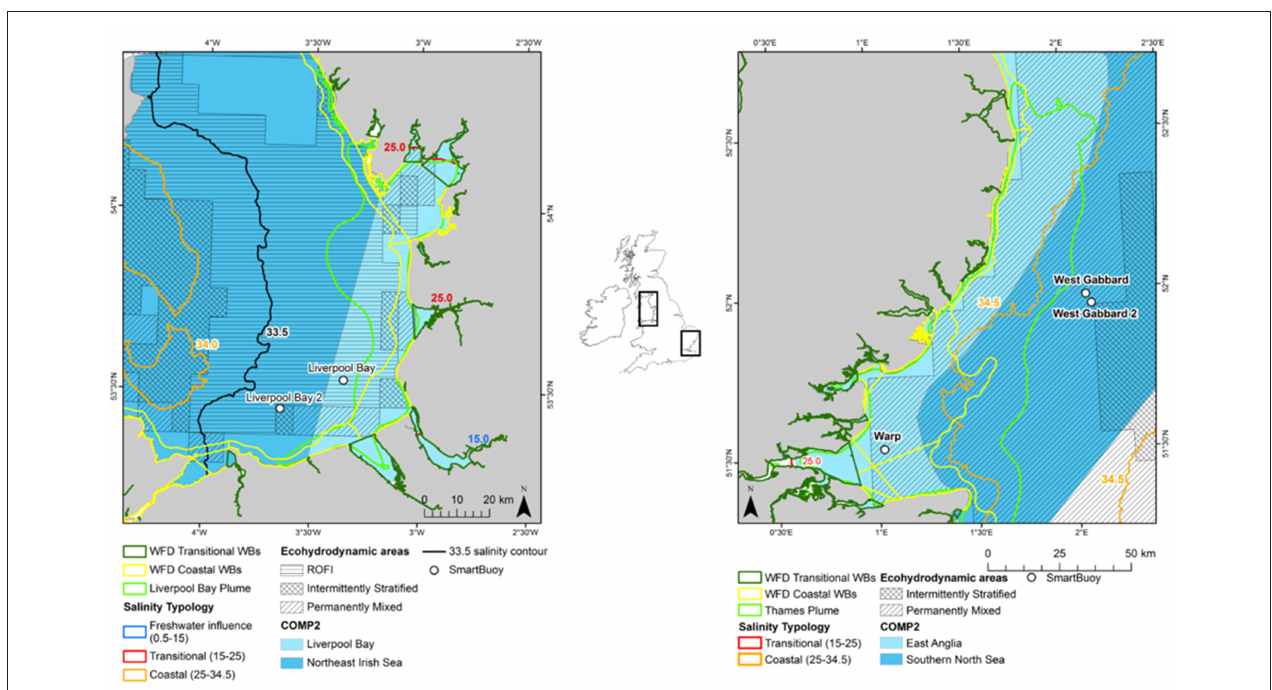
FIGURE 1 | Location of the Liverpool Bay (left) and Thames (right) study areas with the typologies